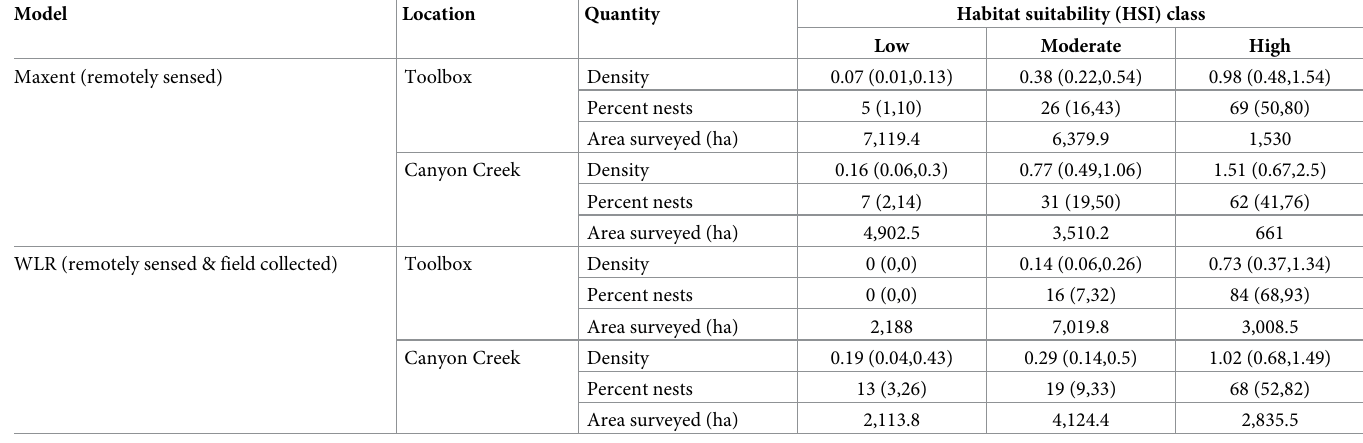
Table 8. Density of hatched nests in suitability classes defined by HSI thresholds based on Maxent and weighted logistic regression (WLR) models (Maxent thresh- olds = 0.34, 0.6; WLR thresholds = 0.3, 0.53). Models were developed with data on nesting white-headed woodpeckers from Toolbox and Canyon Creek burned forest locations (Oregon). 95% CLs (values in parentheses) are bootstrapped with 600 m cells as sampling units. Percent nests is the expected percent of hatched nests assuming equal area sampling across suitability classes. Area surveyed was calculated as the proportion of reference sites (available for Maxent, non-nest for WLR) in each suitability class multiplied by the total area surveyed at each